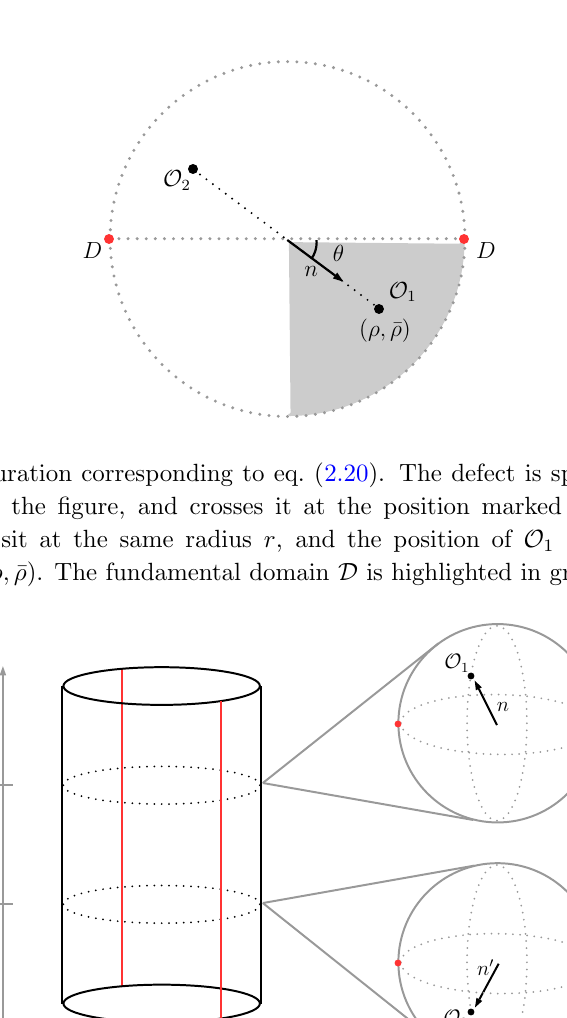
Figure 4 . The con(cid:12)guration corresponding to eq. (2.22). The red lines on the cylinder mark the position of the defect. Constant time slices are spheres, which in this three dimensional example are marked by the defect in two opposite poles. The operators two spheres inserted at time 0 and (cid:28)